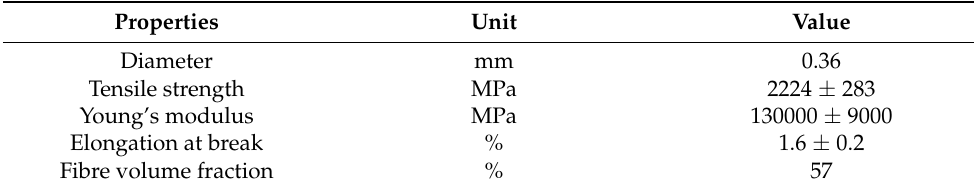
Table 3. CCF tensile test data. For the tensile test, 100 mm of CCF was taken directly from the spool, tabs were glued onto each end for gripping and to reduce damage to CCF during